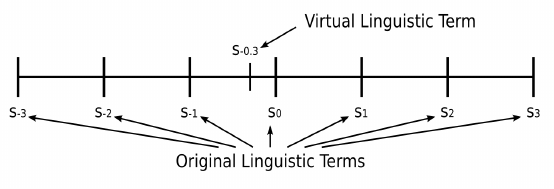
Fig. 3. Example of the linguistic model proposed by Xu